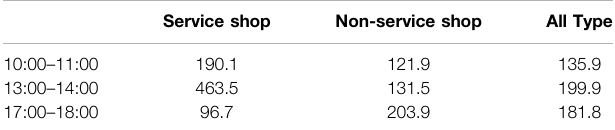
TABLE 1 | Average store utilization duration in three time periods (second). Service